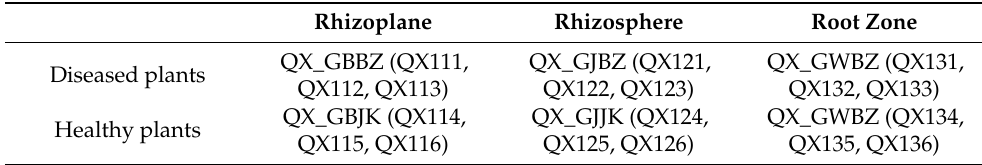
Table 1. Specific sample serial numbers.